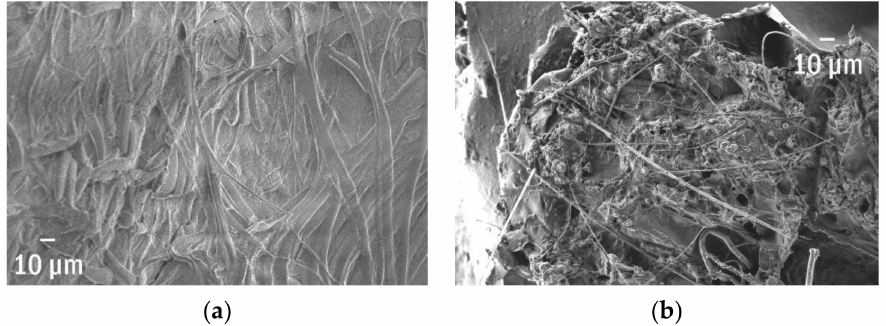
Figure 8. The microplastics (from fish guts of ( a ) cod (the close view of the surface) and ( b ) herring, respectively) and their clear signs of